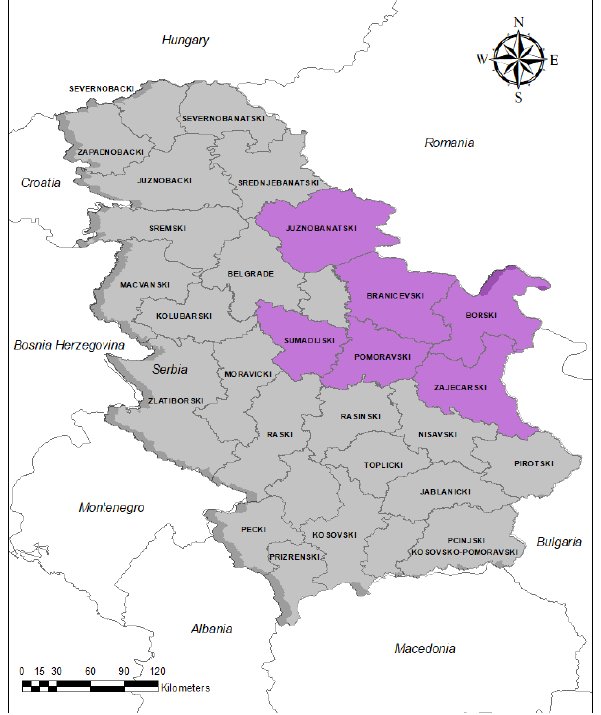
Figure 1. Administrative districts in Serbia where the tested wild boar sera were collected (purple